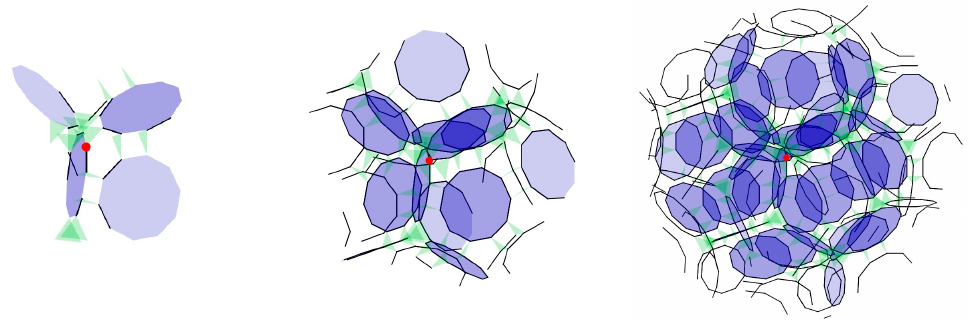
Figure 6. Snapshots of an object in which the scope is gradually increasing from a selected focal point using the focus+scoping technique (L to R).